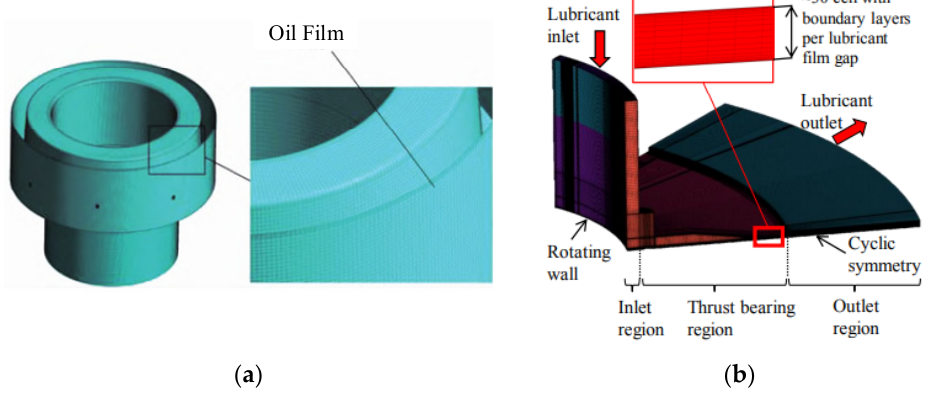
Figure 10. Meshing of oil film clearance. ( a ) Mesh division of the lower guide bearing rotation do- main and oil film [116]; ( b ) rotation periodicity calculation domain and oil film meshing [104].